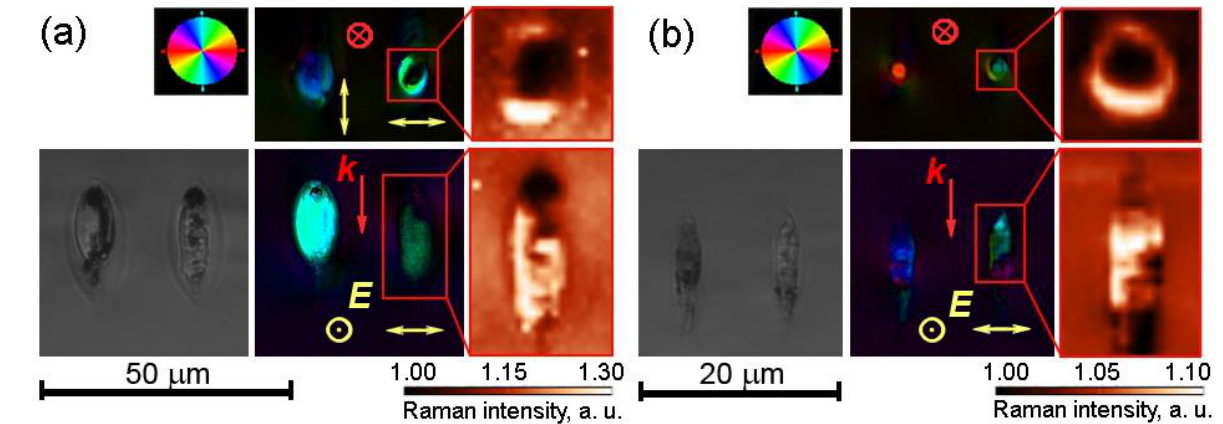
Figure 1. Brightfield optical images (OI) of the side view and pseudocolor maps of the orientation of the slow axis of birefringence (SAB) of the dots written in SG22 glass by 10 6 laser pulses per dot at the pulse duration of 1.2 ps and the pulse energy of 210 nJ ( a ) and 120 nJ ( b ) and the varied PRR and polarization plane orientation E (indicated in yellow). The notation k (indicated in red) is for the wave vector direction.